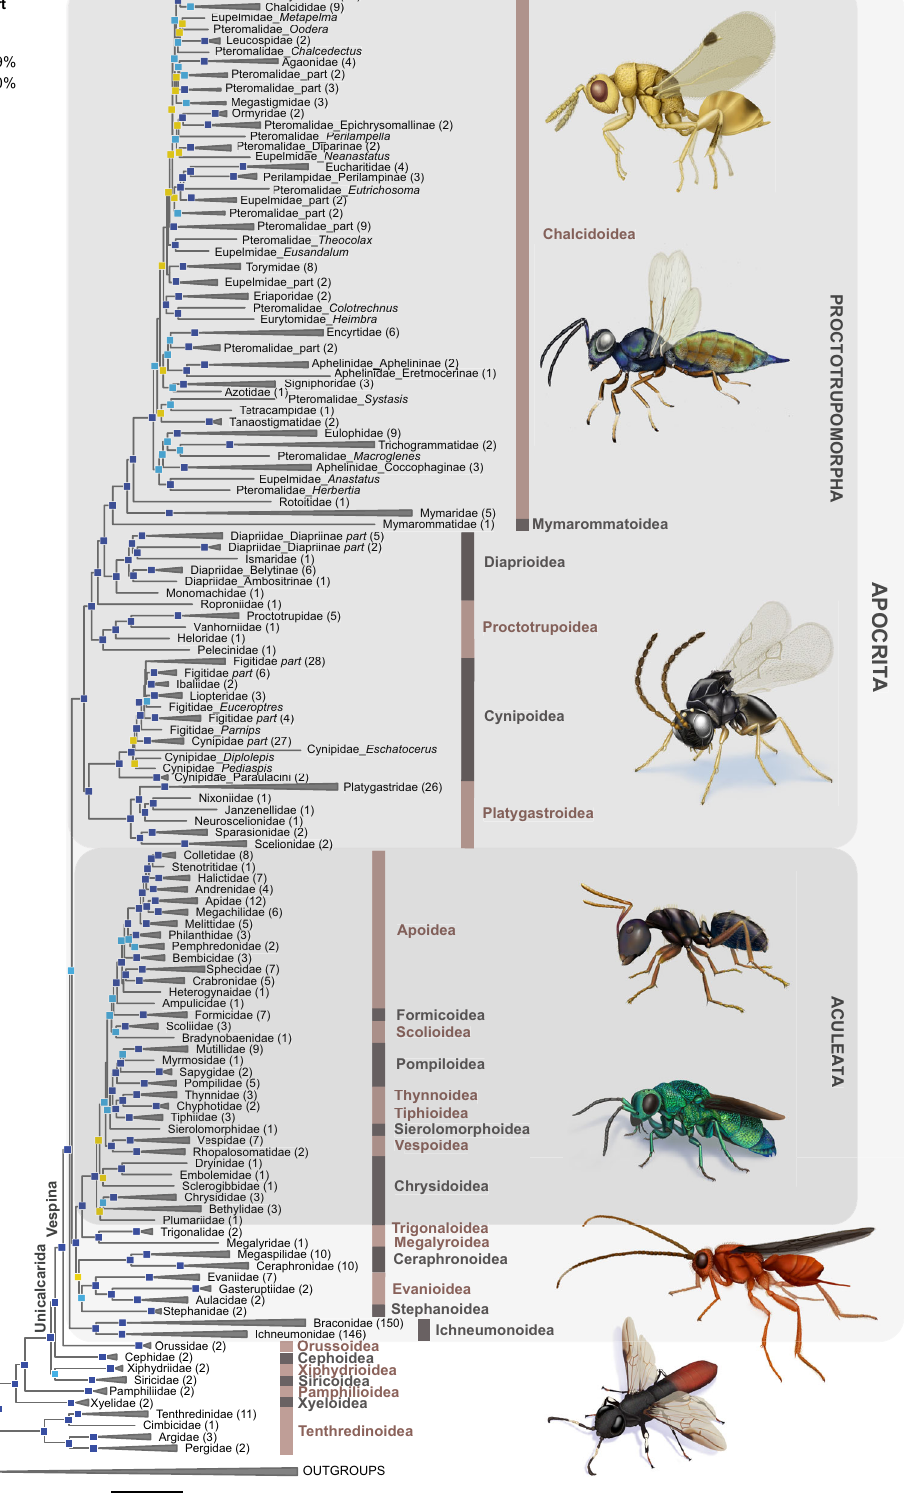
Fig. 1 | Family-level phylogeny of Hymenoptera. Phylogeny shows relationships between hymenopteran families as estimated from 446 UCE loci in the nuc-70%- SWSC analysis. This data set was partitioned using the Sliding-Window Site Char- acteristics Entropy (SWSC-EN) algorithm 106 and PartitionFinder2 107 in combination with the r cluster algorithm 108 and analyzed using Maximum Likelihood (ML) best- treeandultrafastbootstrapsearchesinIQ-TREEv1.6.10 109 .Thisresultisreferredto astopologyC-1(topC-1)throughout the textand the remaining fi gures and tables.